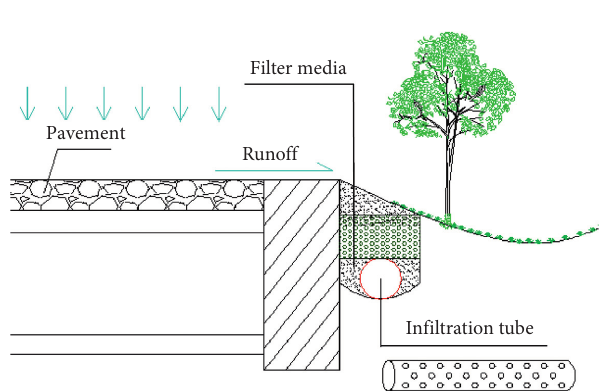
Figure 1: Illustration of an infiltration gutter